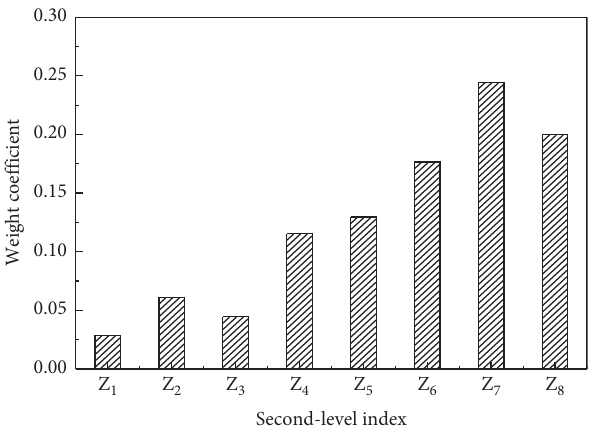
Figure 3: The weight coefficient of secondary layer index on the assessment of college E&I education effect.